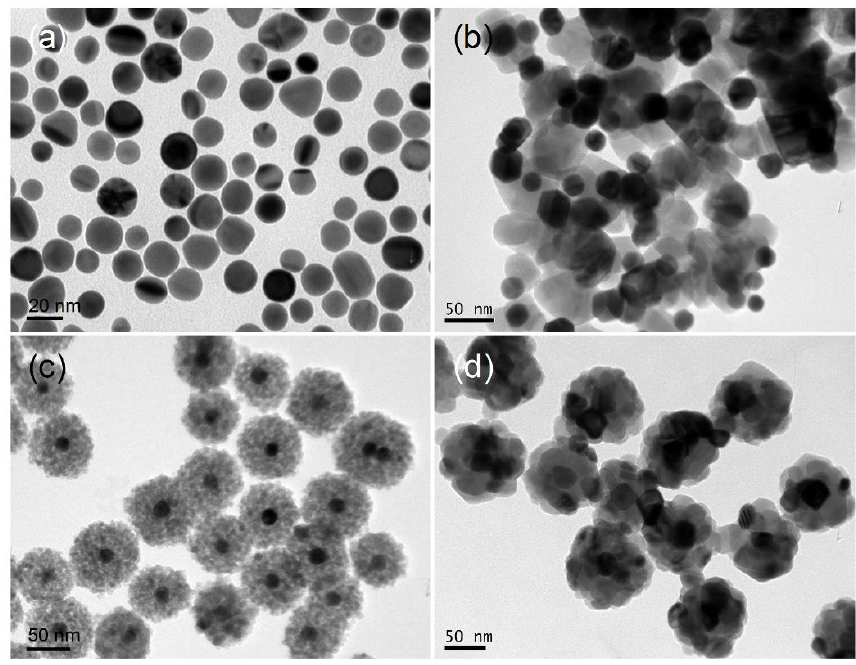
/ ZnO ( b ), and Au@ZnO with porous ( c ) and dense ( d ) Figure 1. TEM images of Au ( a ), Au/ZnO ( b ), and Au@ZnO with porous ( c ) and dense ( d ) shells. Figure 1. TEM images of Au ( a ), Au